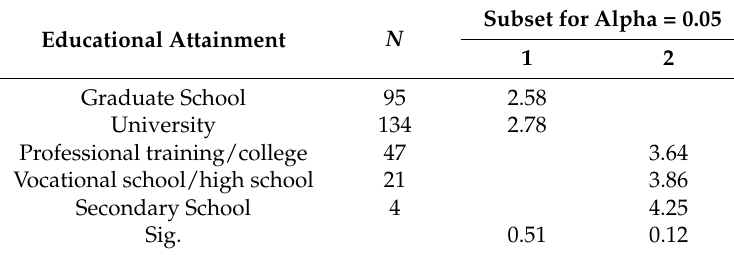
Table 5. Public’s subsidies expectations of different educational attainment.